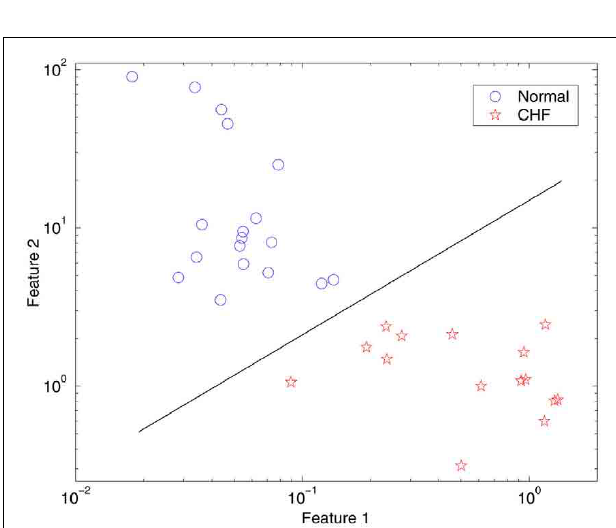
FIGURE 10 | Feature plane separating normal subjects from subjects with CHF, where Feature 1 quantifies the goodness-of-fit of Eq. 14 to the actual SDLE curve, and Feature 2 is related to how well the characteristic scale ε ∞ is